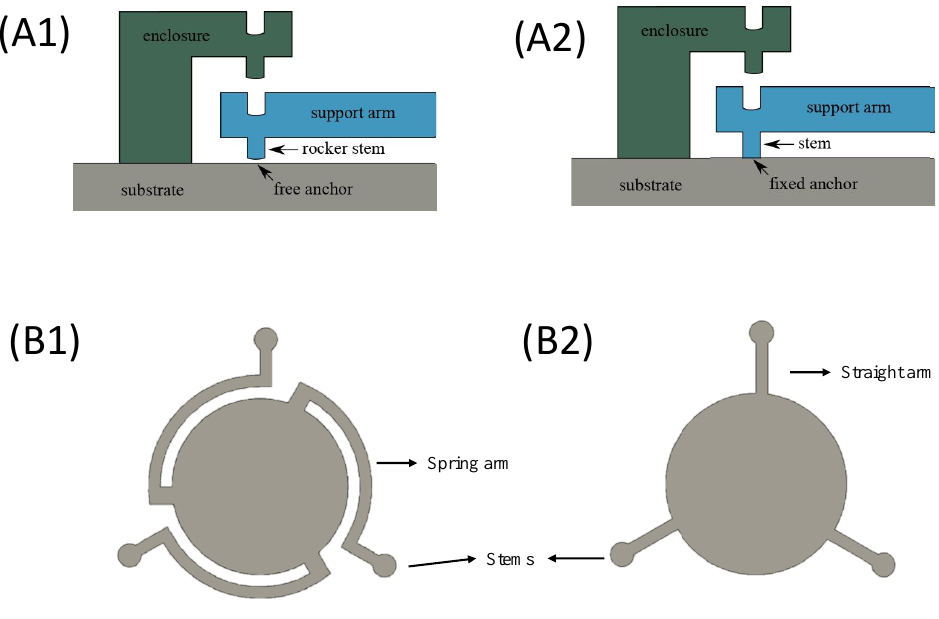
Figure 6. Illustration of the different anchoring (rocker ( A1 ) and fixed ( A2 ) stems) and support (spring ( B1 ) and straight ( B2 ) arms)